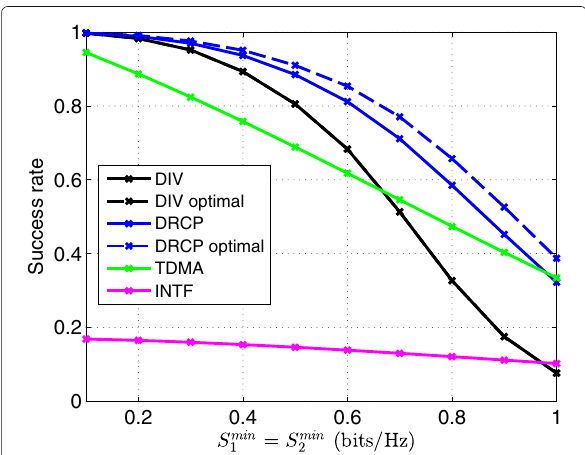
Fig. 12 Success rate of the studied approaches in the circuit power-dominated regime with equal average